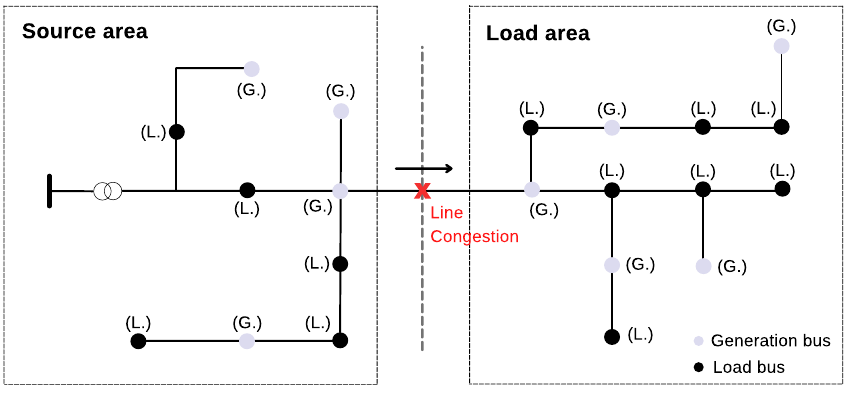
Figure 4 . The partitioning zones . Figure 4. The partitioning